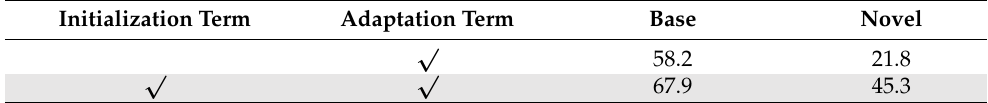
Table 6. The ablation of meta-learner module F